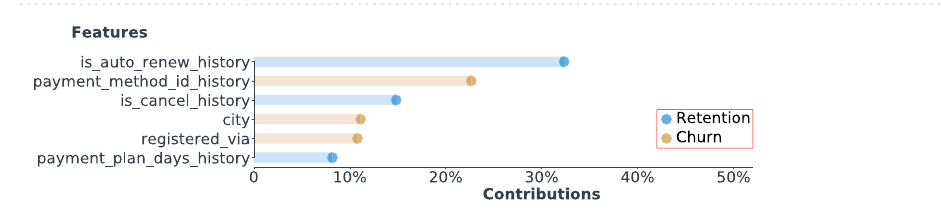
(a) The representative ‘data genomes’ of customers likely to churn identified from the representations learned by Table2Vec.